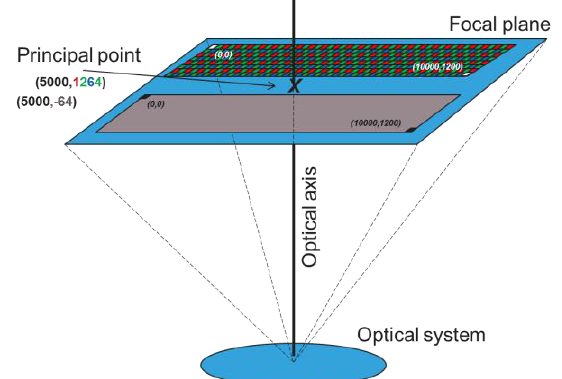
Figure 9 layout of the focal plane of the MEDUSA engineering model camera